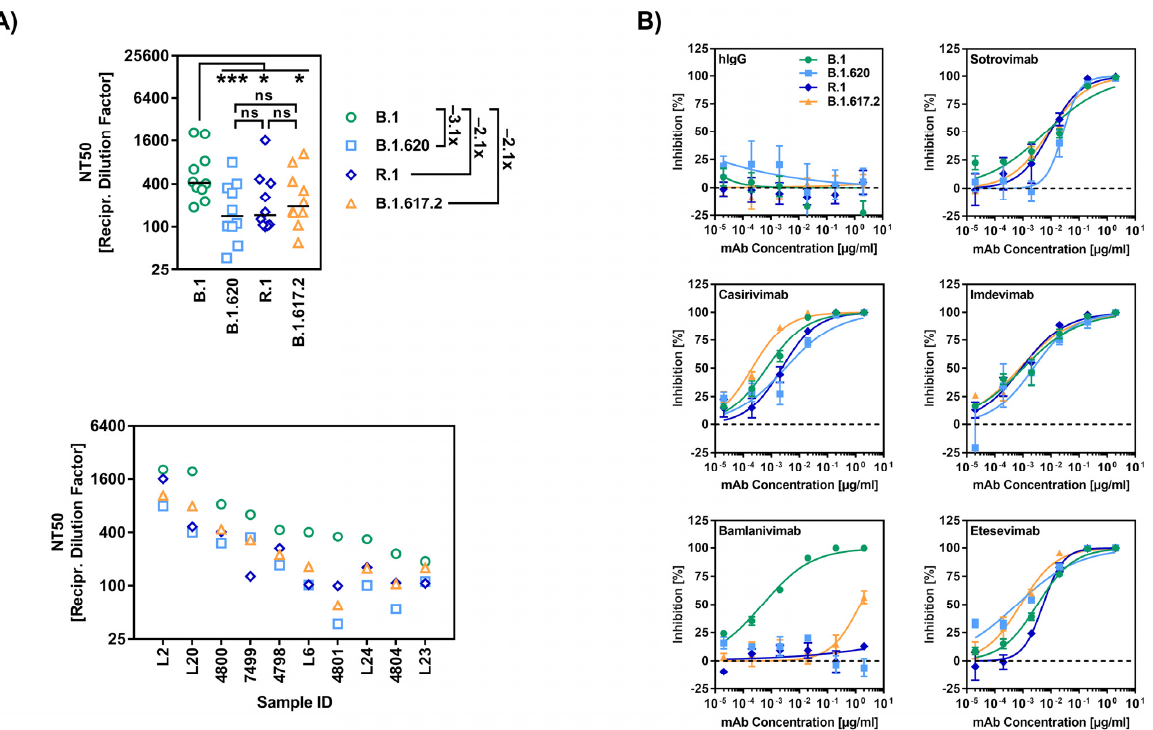
Figure 2. SARS-CoV-2 lineages B.1.620 and R.1 evade antibody-mediated neutralization. ( A , B ) The S proteins of SARS-CoV-2 B.1.620 and R.1 evade neutralization by antibodies induced by vaccination or employed for COVID-19 therapy. S protein-bearing particles were incubated at 37 °C for 30 min in the presence of the indicated plasma samples from BNT/BNT or AZ/BNT vaccinated individuals (panel ( A )) or therapeutic monoclonal antibodies (panel ( B )) before being inoculated onto Vero cells. Transduction efficiency was quantified as stated for Figure 1D and used to calculate the plasma dilution factor that leads to a 50% reduction in transduction (NT50, panel ( A )). Data for ten serum samples from vaccinated donors are presented. Black lines indicate the median and numbers on the right represent the fold change in NT50 compared to B.1. Statistical significance of differences between individual groups was analyzed by Friedman test with Dunn’s multiple comparisons test (panel ( A ); p > 0.05, ns; p ≤ 0.05, *; p ≤ 0.001, ***; please see also Figure